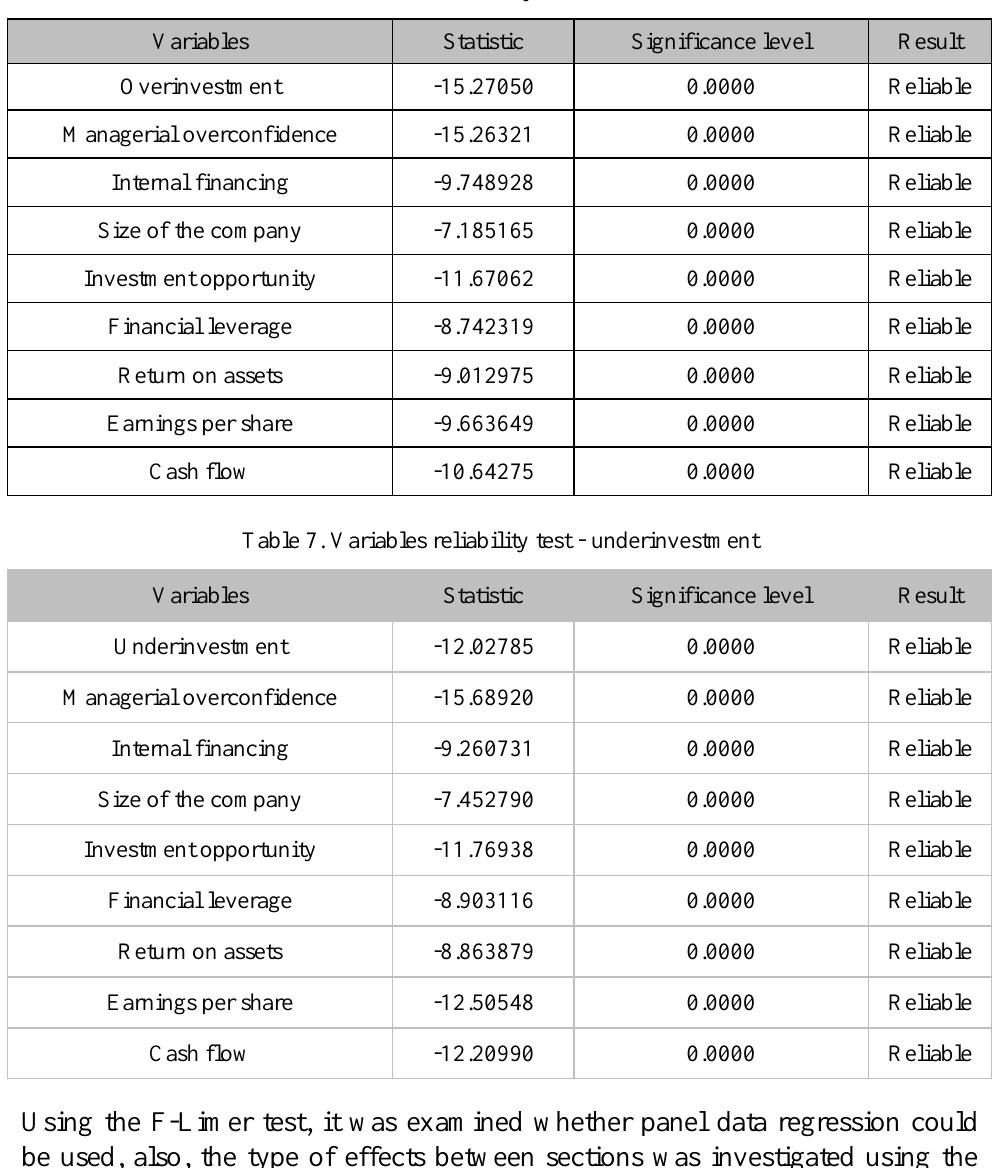
Table 6. Variables reliability test - overinvestment